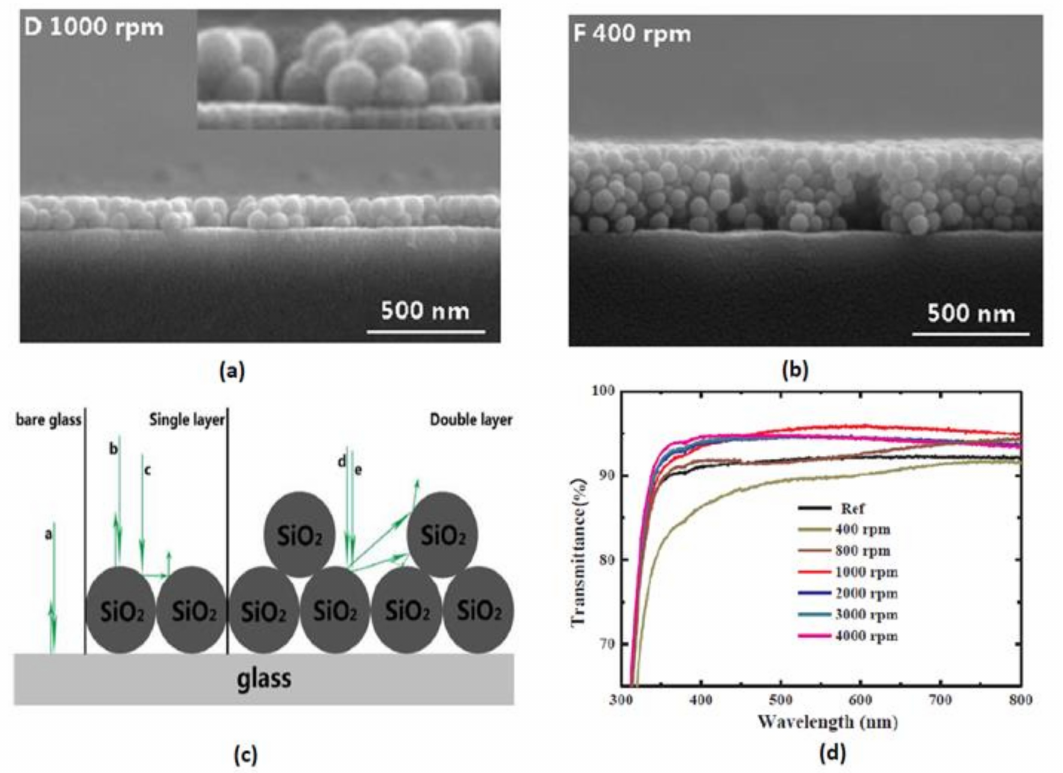
Figure 17. ( a , b ) FESEM images of spherical SiO 2 coating deposited on glass substrates with various spin-coating speeds. ( c ) Schematic illustration of the light interaction with SiO 2 sphere-based ARCs. ( d ) Variation of transmittance for spherical SiO 2 based AR coatings on glass substrate at various speeds (Ref—Glass sample without coating). Reprinted with permission [119]; 2018,